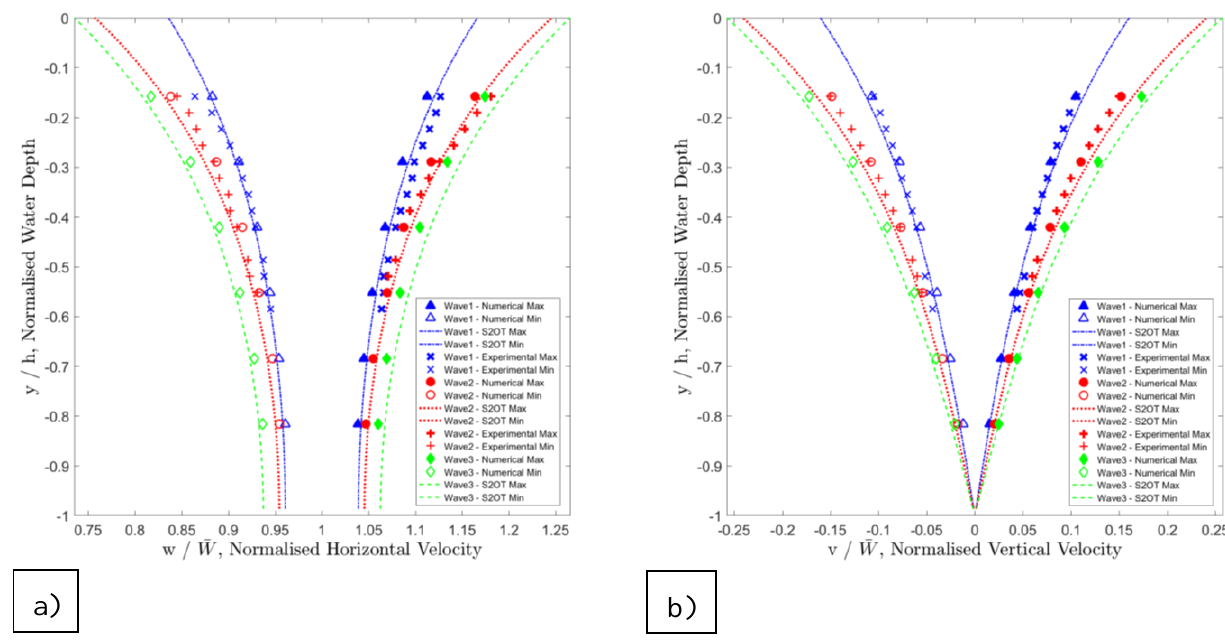
Figure 15. The normalised a) horizontal and; b) vertical velocities at monitor points through the water depth at a location 4m downstream of the inlet for numerical results, experimental results and